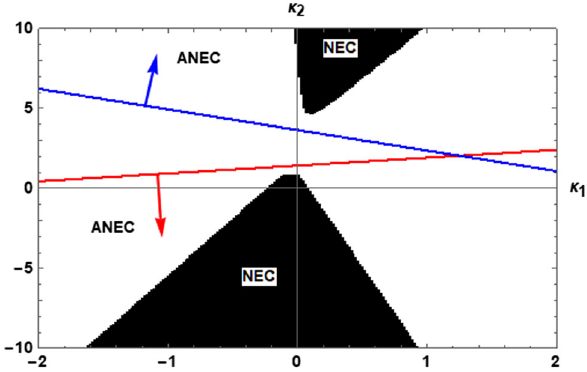
Fig. 2 The regions of validity for NEC and ANEC. The size of the wedges depend on the values of A , B and ˜ L . This graph is depicted for the special values, d = 4, A = ± 0 . 1, B = − 2 and ˜ L = 1 . 2. The ANEC holds below the red line for A < 0 and above the blue line for A >